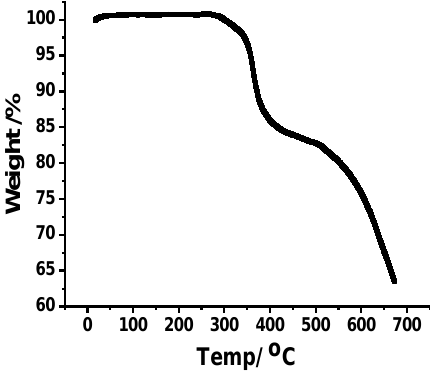
Figure 3. TGA curves of complex 1 .